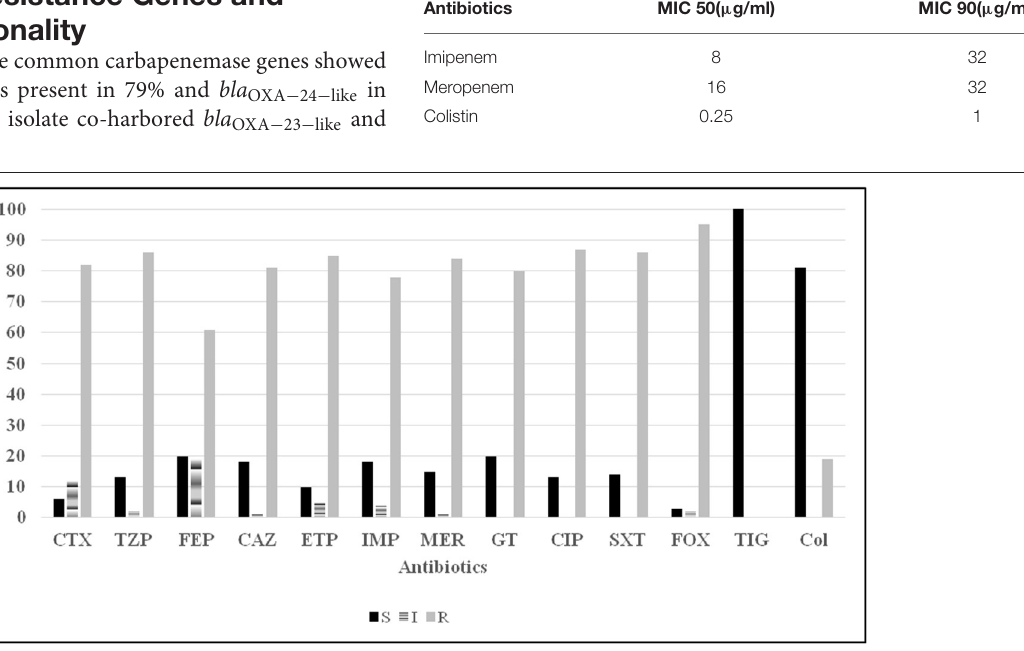
FIGURE 2 | Antibiotic susceptibility (disc diffusion method) profiles for 100 Acinetobacter spp. isolates. CTX, cefotaxime; TZP, tazocillin; FEP, cefepime; CAZ, ceftazidime; ETP, ertapenem; Imp, imipenem; MER, meropenem; GT, gentamicin; CIP, ciprofloxacin; SXT, trimethoprim sulfamethoxazole; FOX, cefoxitin; TIG, tigecycline; Col,